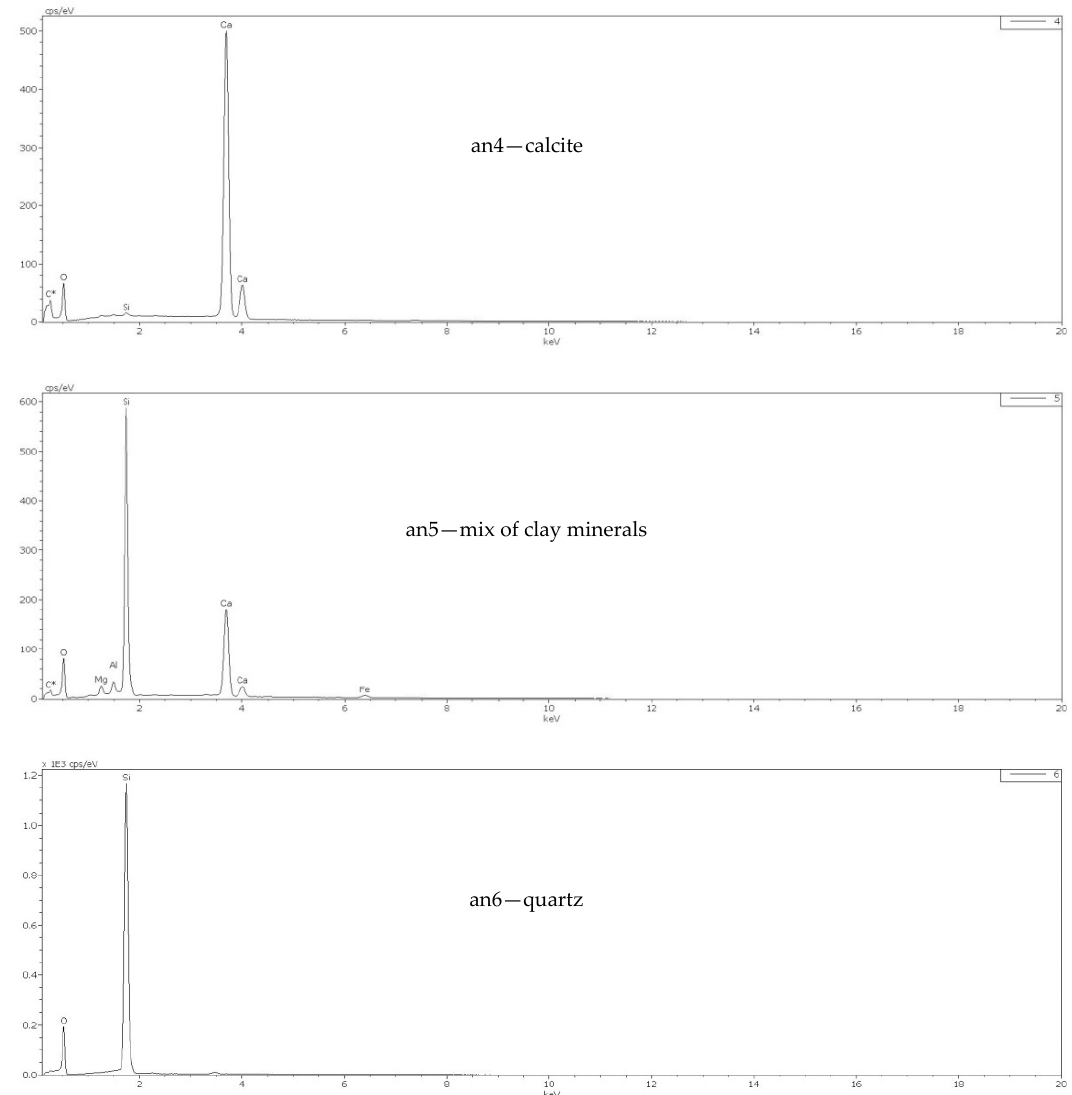
Figure A2. EDS spectra of grains with different shades of grey indicate different chemical composition.